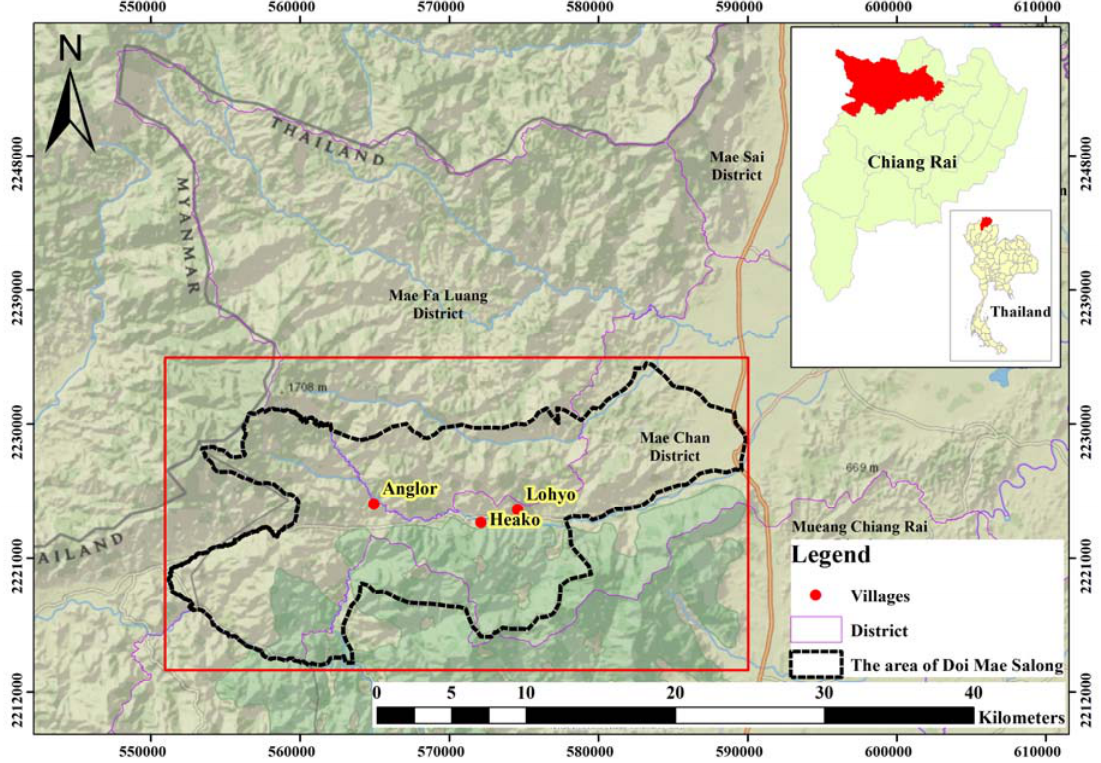
Figure 1. Location map of Doi Mae Salong area, Chiang Rai.